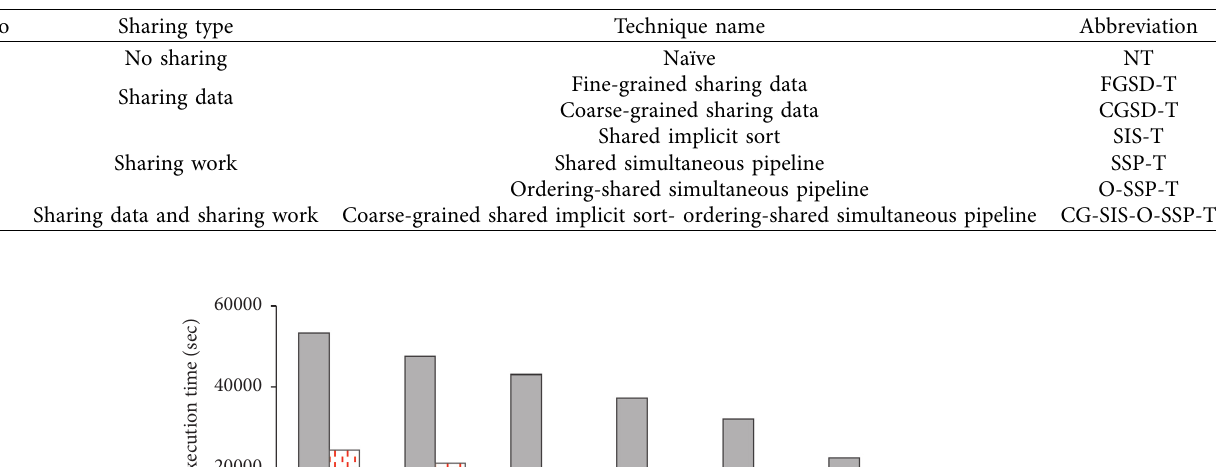
Table 7: The J-MOTH multiway join optimization techniques.